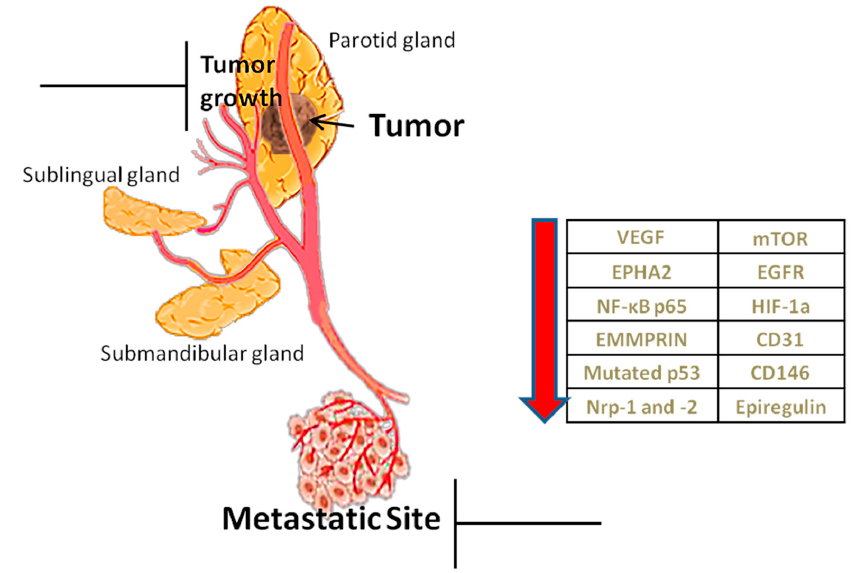
Figure 1. Role of angiogenesis and factors implicated. Angiogenesis helps in the growth of the tumor through the transfer of nutrients but also in its metastasis. The table shows angiogenic factors, which, when reduced by inhibitors, prevent tumor growth and